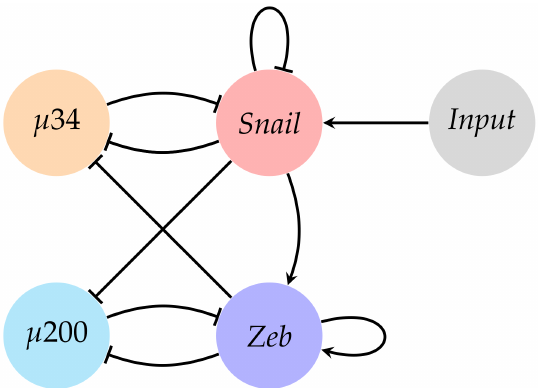
Figure 5. Gene circuit of the Epithelial-Mesenchymal Transition (EMT).